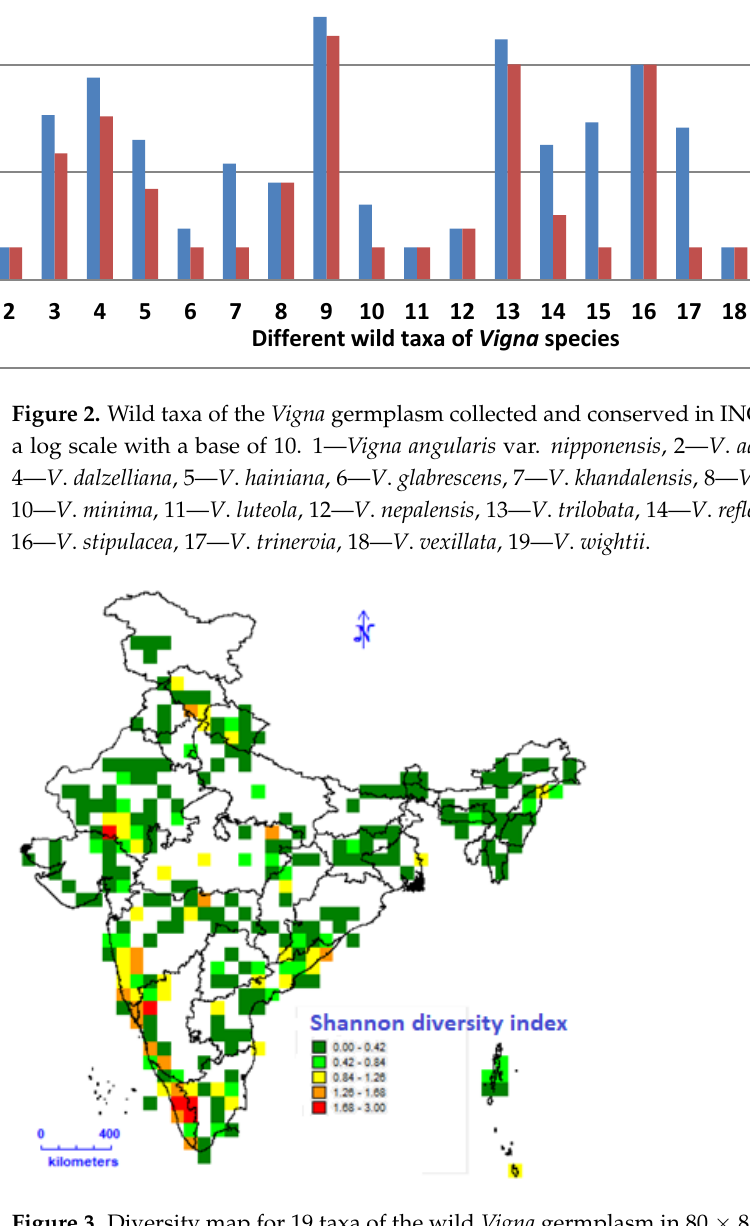
Figure 3. Diversity map for 19 taxa of the wild Vigna germplasm in 80 × 80 km grid cells using the Shannon Diversity Index